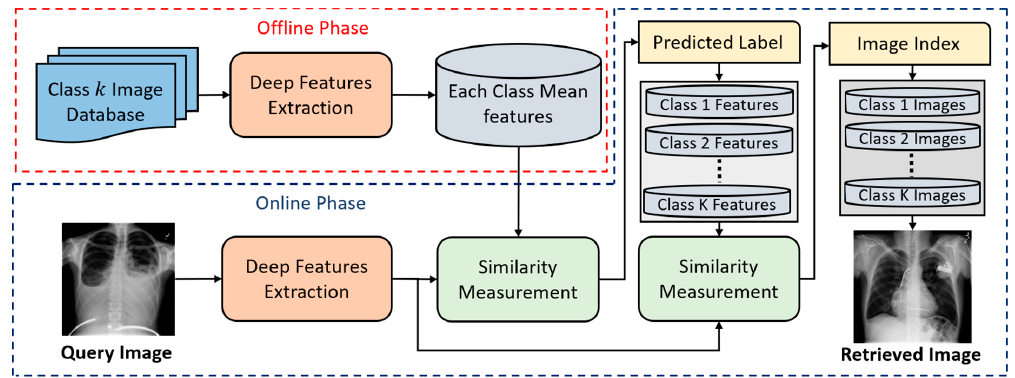
Figure 15. The class-prediction-based content-based medical image retrieval (CBMIR) system by using our proposed deep CNN model.